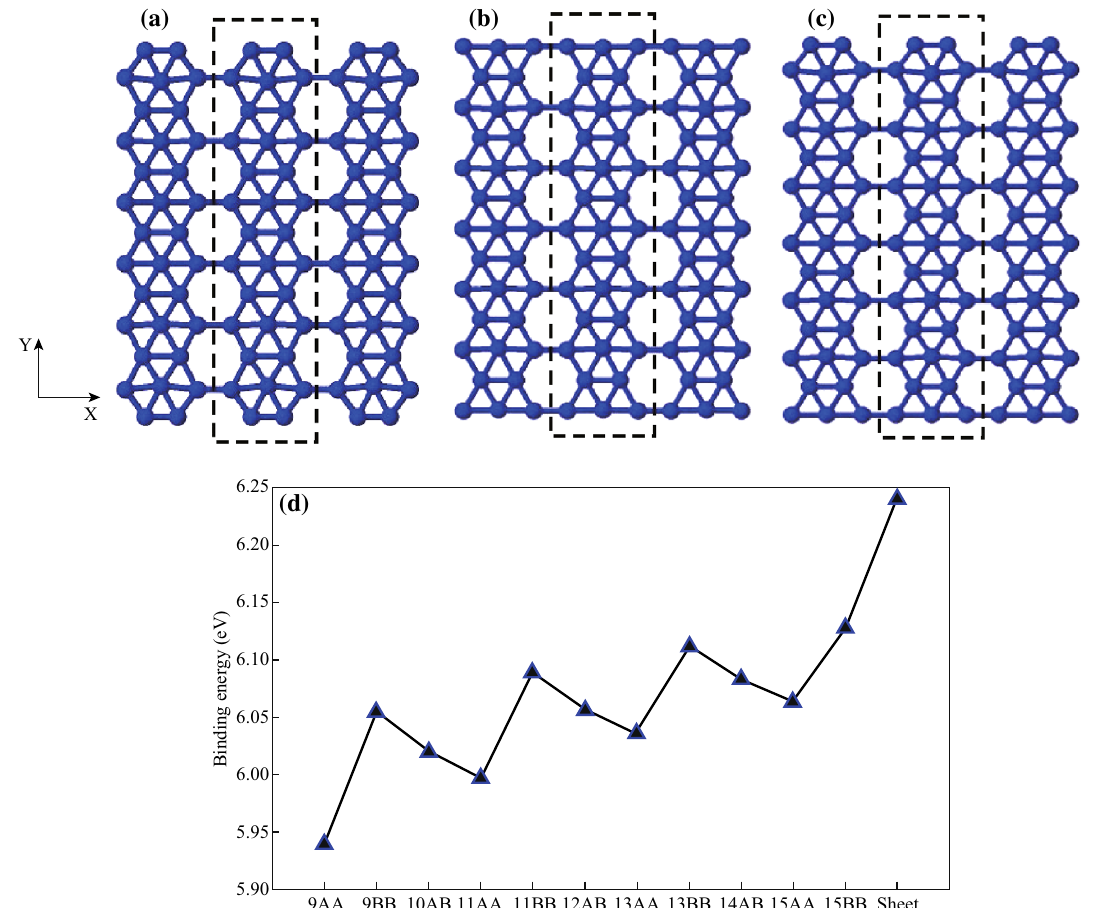
Fig. 2 Structure of a 13AAXBNR , b 13BBXBNR , and c 14ABXBNR . d The binding energy of the considered structures. The dashed rectangle shows the unit cell of each